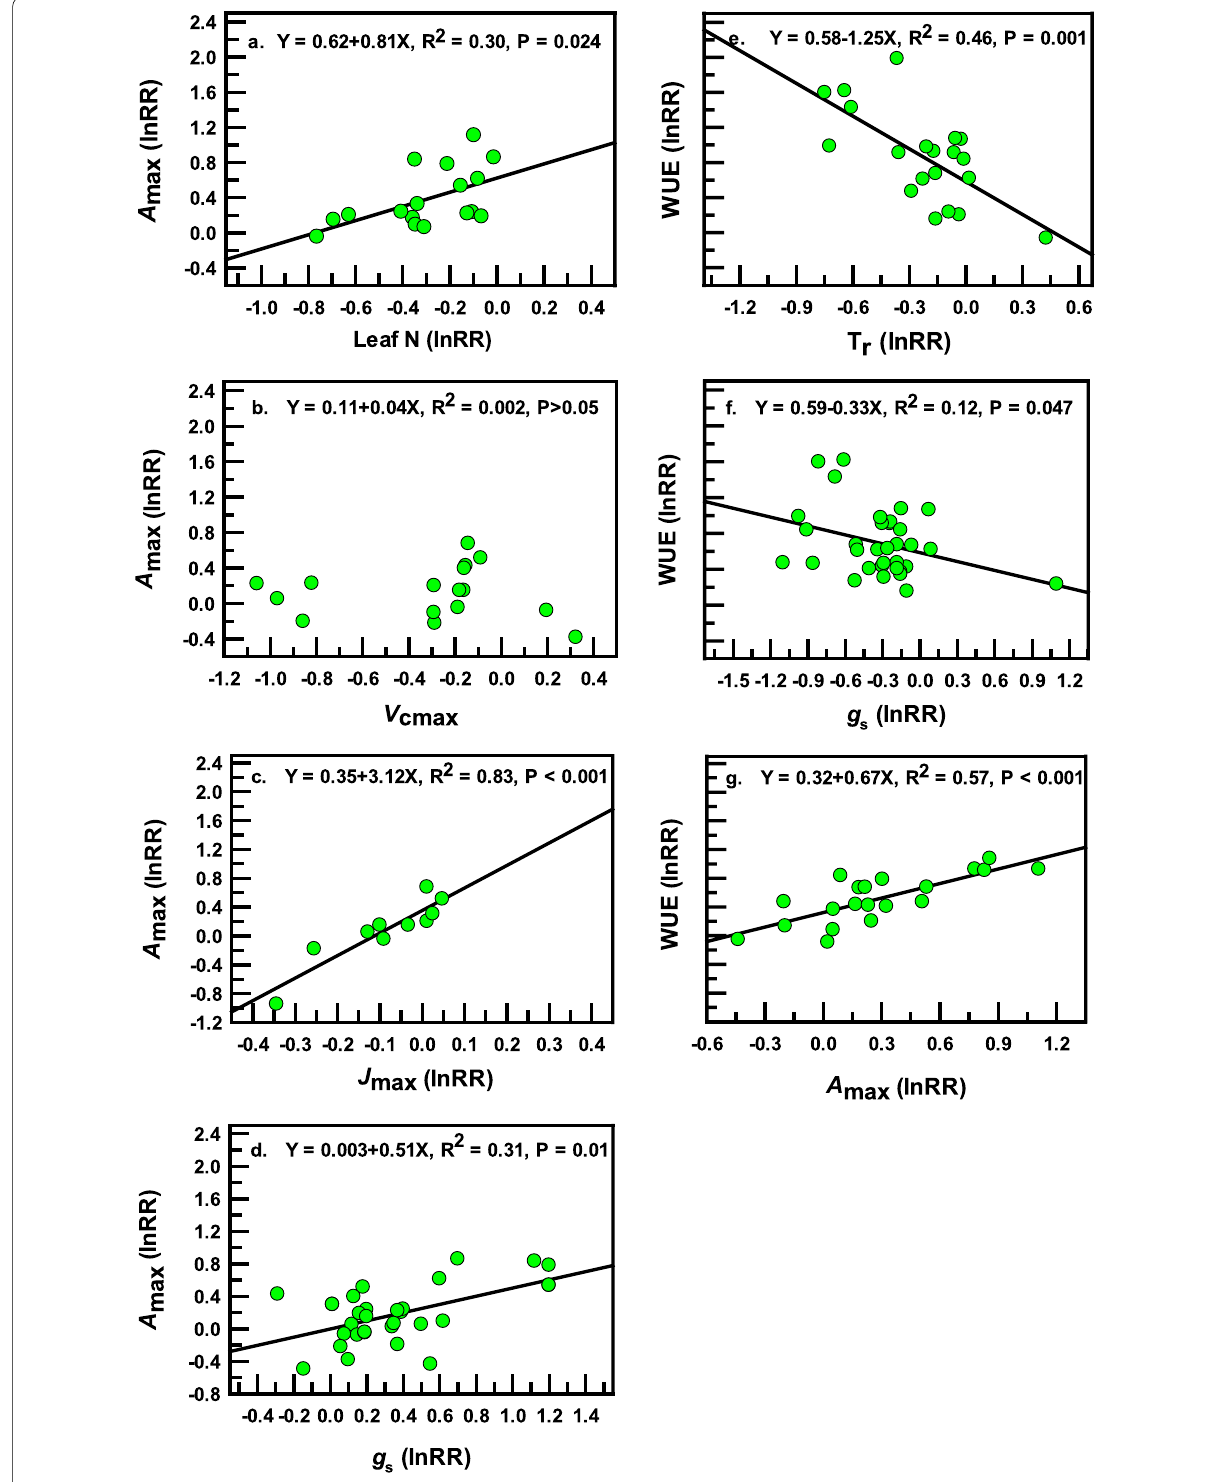
Fig. 3 The relationships between photosynthesis ( A max ) and leaf N, photosynthetic Rubisco carboxylation ( V cmax ) and photosynthetic electron transport rate ( J max ) from a to d and water use efficiency (WUE) and transpiration (Tr), stomatal conductance ( g s ) and A max from e to